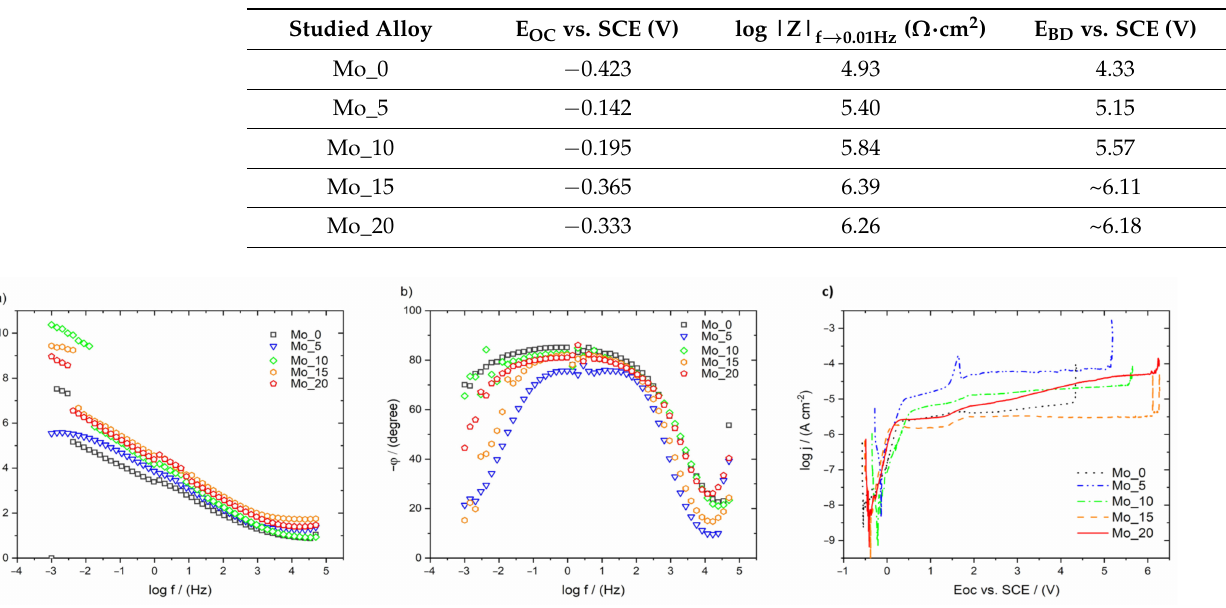
Table 5. Open circuit potential and the log |Z| f → 0.01Hz value registered for studied alloys with different Mo content.